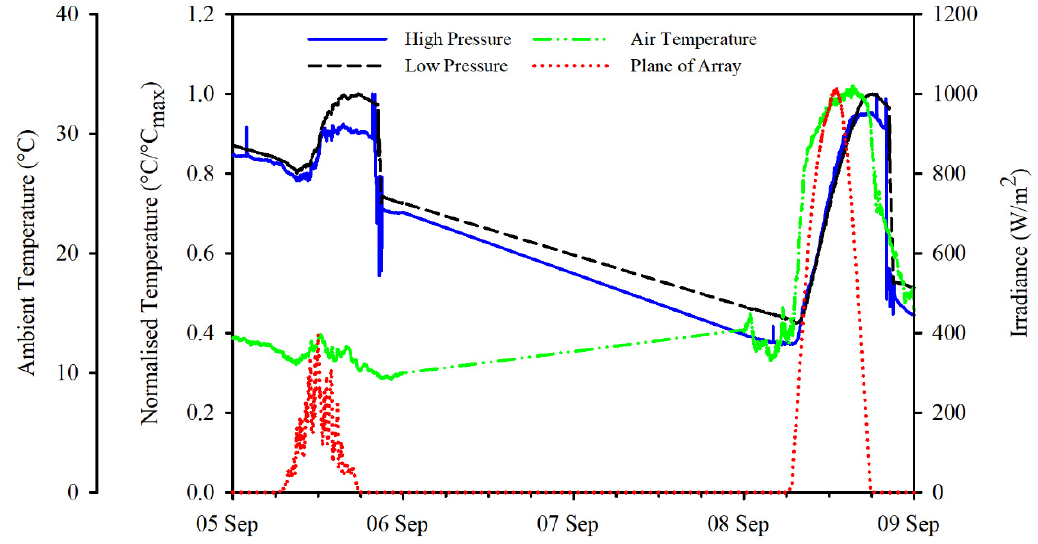
Figure 12. Normalised clear and cloudy day for the FP and ET systems and their response to ambient temperature. Equation (3) was used to calculate the efficiencies of the FP and ET systems on a clear and cloudy day.